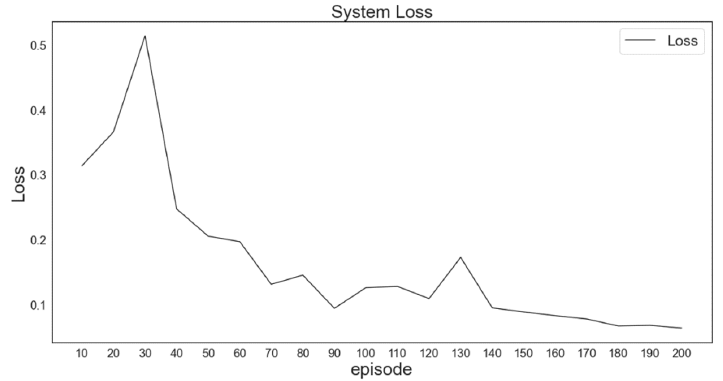
Figure 11. Loss function after training with 25 data for 200 generations.